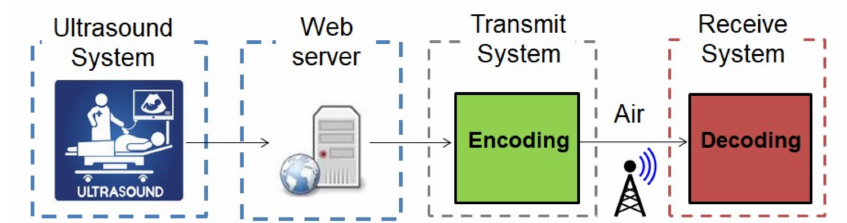
Figure 1. Flow chart of proposed tele-ultrasound system